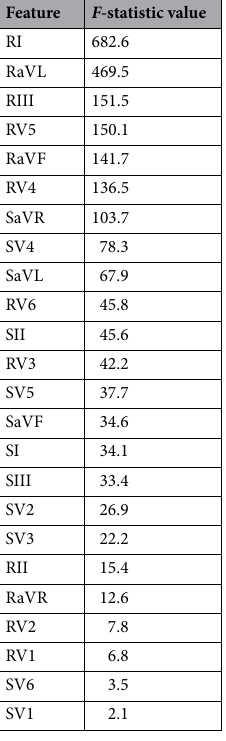
Table 5. F -statistic values of adopted features.